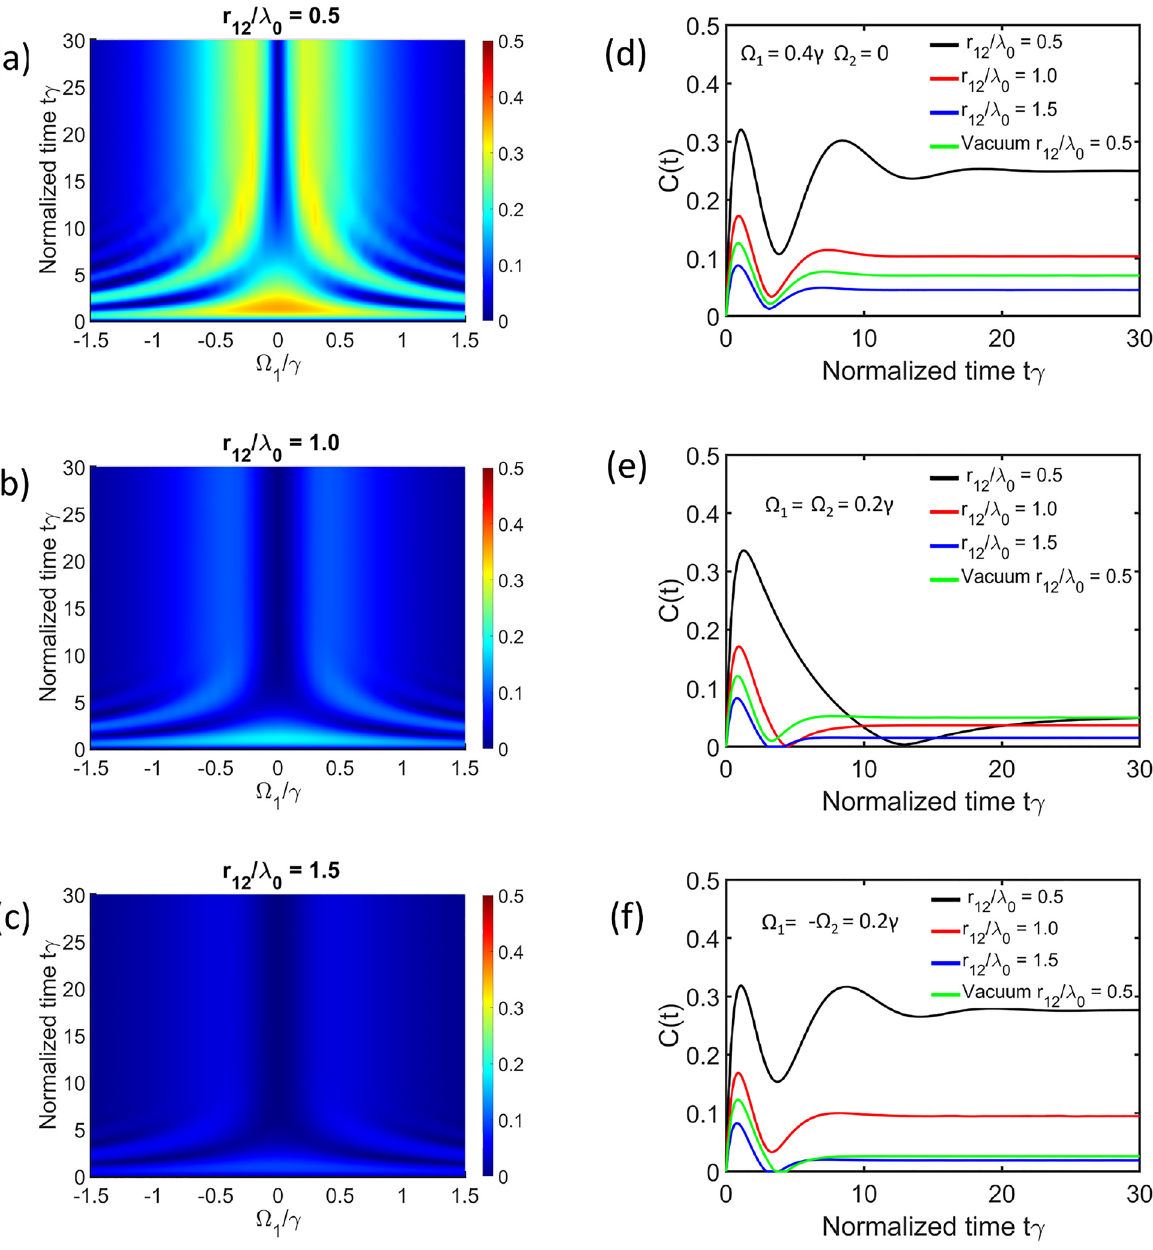
Figure 6: Persistent time dependent concurrence as a function of an external coherent source. The time dependent concurrence for different ∕ 𝛾 of a single pump source ( Ω ∕ 𝛾 = 0) for different normalized interatomic distances (a) r Rabi frequencies Ω 1 2 ∕ 𝜆 = 1 . 5. Time dependent concurrence between two quantum emitters at different normalized interatomic distances for different and (c) r 12 0 = 0 . 4 𝛾, Ω = 0), (e) symmetric ( Ω external pumping (d) asymmetric ( Ω 1 2 plot of the homogeneous medium is illustrated by the plot legend vacuum r ∕ 𝜆 = 0 . 5) (see Supplementary for reservoir ( r 12 0